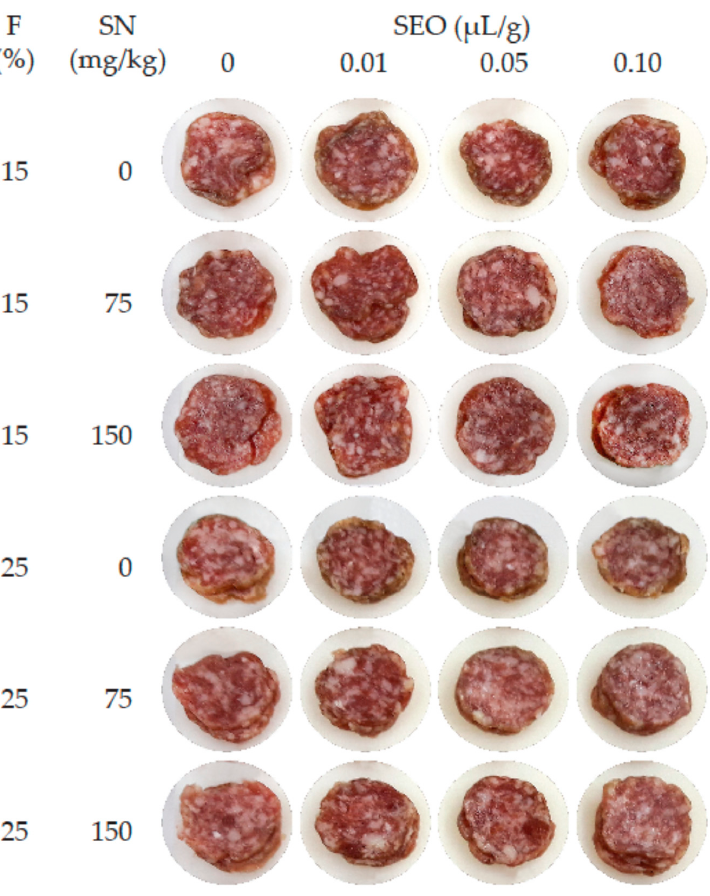
Figure 1. Photograph of the inside surfaces of the sausages at the end of storage. DFS—dry fermented sausages; F—fat; SN—sodium nitrite; SEO—sage essential oil; S—storage.